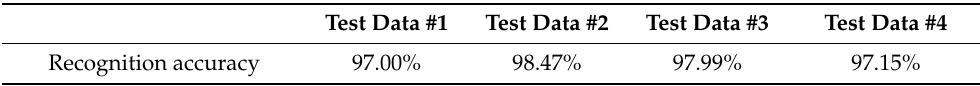
Table 1. The accuracy of the neural network on the test data.